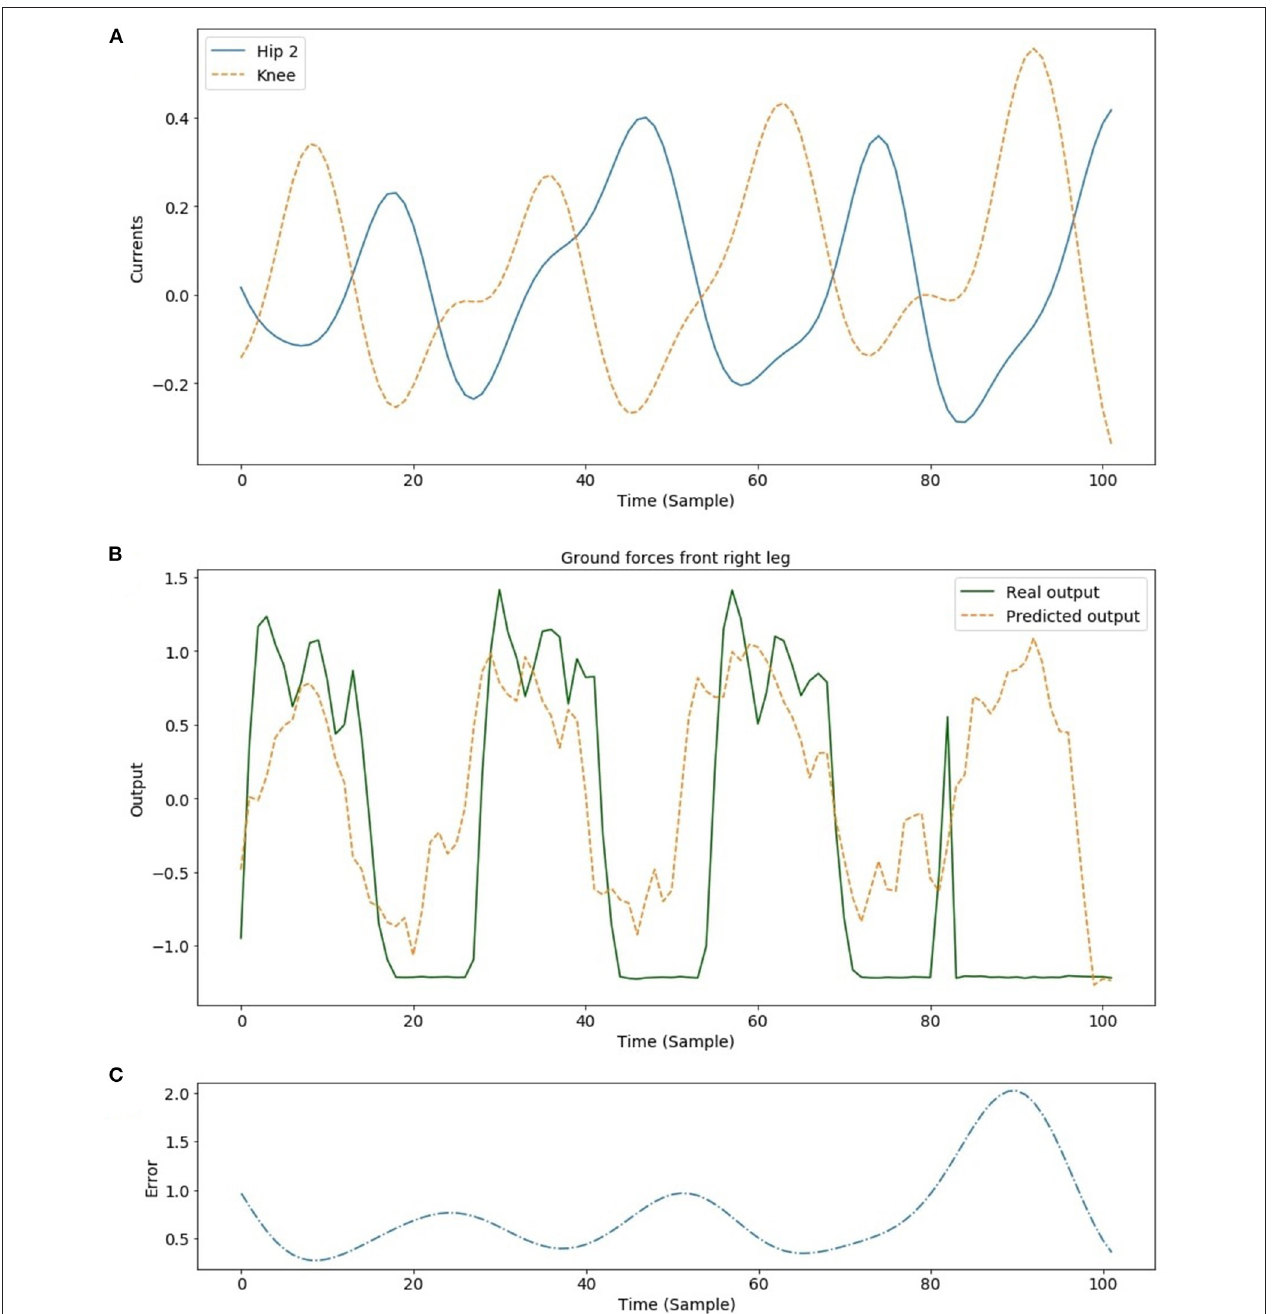
FIGURE 12 | Input and output signals for the ESN trained to predict the GRF of the front right leg of the Lilibot quadruped robot: (A) the trend of the filtered motor currents on the Hip 2 and Knee robot joints; (B) the comparison between the estimated and actual GRF acquired from the real robot during the testing phase; (C) the prediction error where the presence of an unexpected situation is highlighted by the increased values in the error